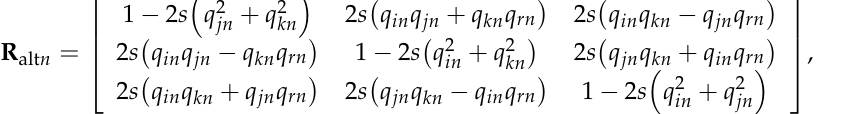
where the vector’s scalar/real part is s , that is s = || q || − 2 . The quaternion will only rotate For any unit vector that will express first segment orientation and rotation, a rotation the unit vector; therefore, s = 1. For clockwise rotation around the same axis by an angle matrix (cid:1792) (cid:3041) exists. This rotation matrix rotates any vector by an angle (cid:2016) (cid:3041) counter-clock- θ n , the quaternion rotation matrix is as follows: wise (right-hand rule) by using